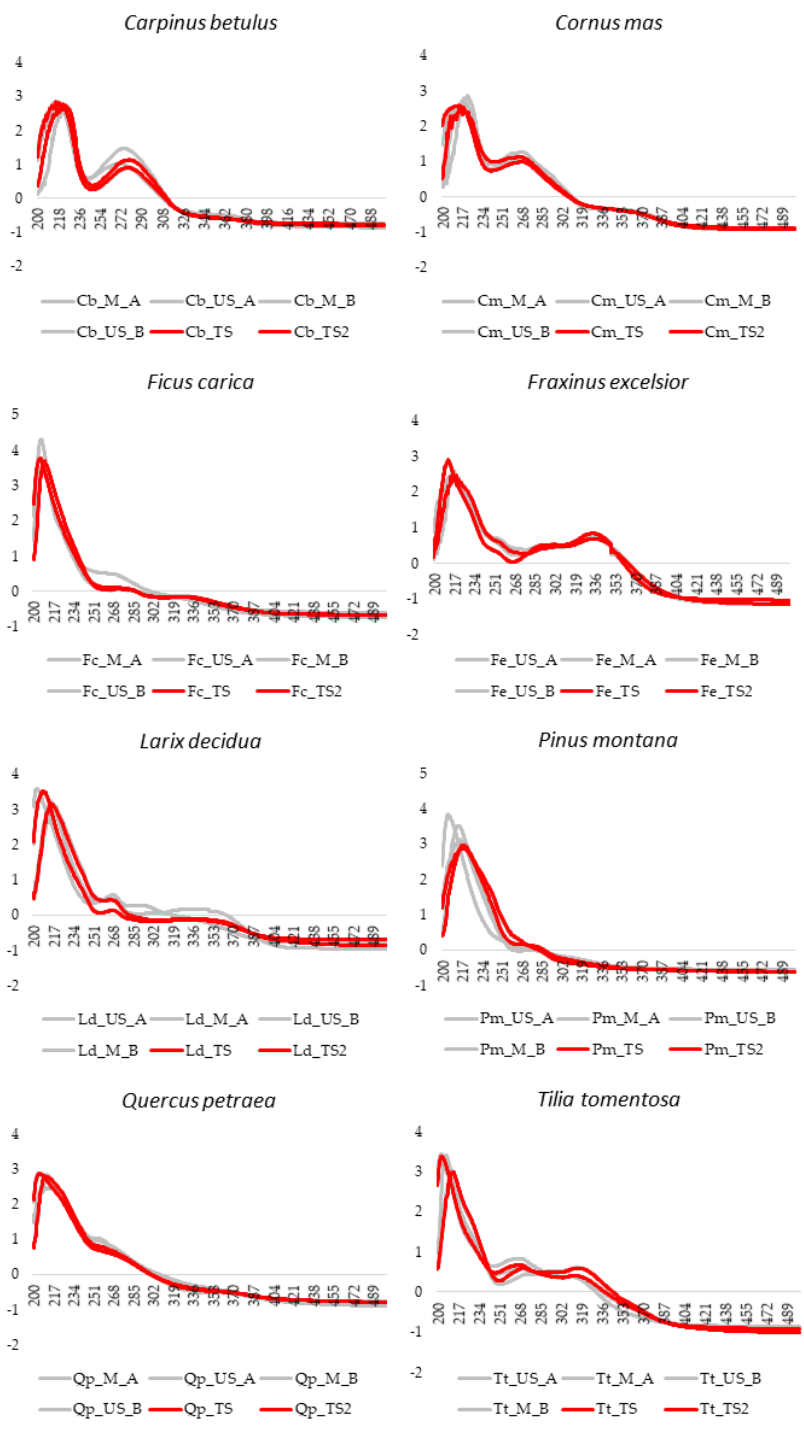
Figure 2. Averaged UV-Visible spectra of the 8 botanical species after SNV pre-treatment of data. For each species, the four averaged spectral profiles of the Calibration set (Table 2) are highlighted in grey while in red are reported the External Test set samples (Table 3).